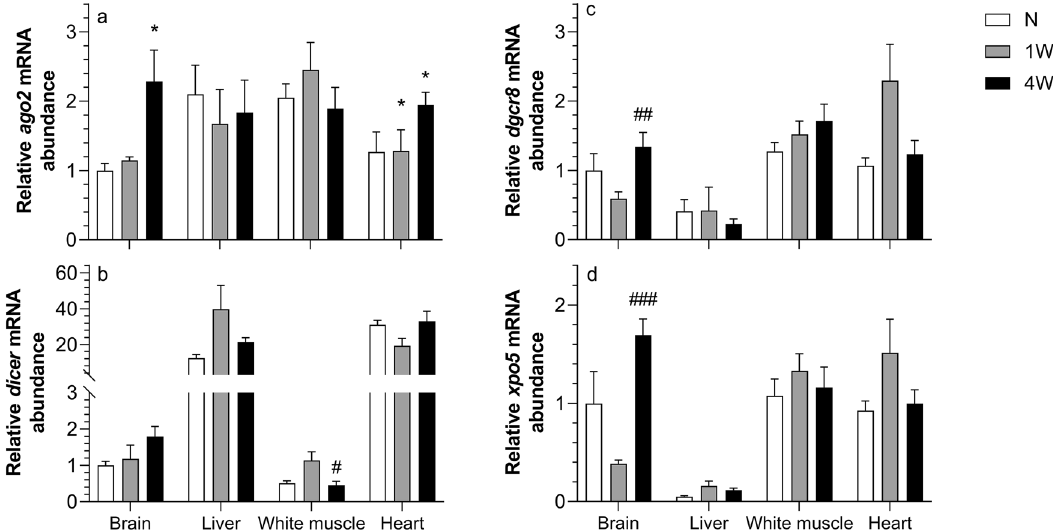
Figure 3. Relative abundance of transcripts involved in the canonical miRNA biogenesis pathway ( ago2 , panel ( a ); dicer , panel ( b ); dgcr8 , panel ( c ); xpo5 , panel ( d )) in tissues of normoxic controls (N), 1-week hypoxic (1WH) and 4-week hypoxic (4WH) goldfish. Values are means ± standard error of the mean (s.e.m.); sample size = 7–12 per group. Differences between normoxia and chronic hypoxia are indicated as *( p < 0.05). Differences between 1 and 4WH are indicated as #(p < 0.05), #(p < 0.01) and ###(p < 0.001).